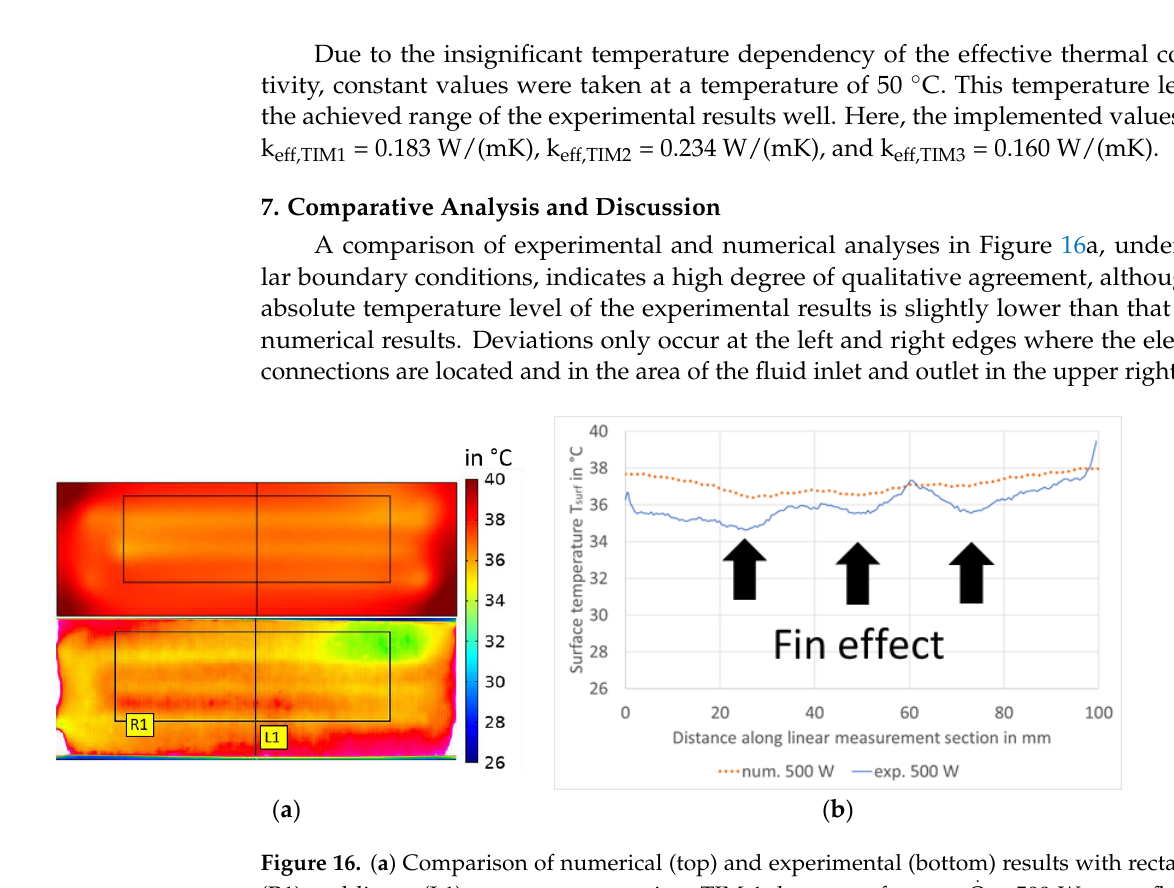
. Q = 500 W, mass flow rate